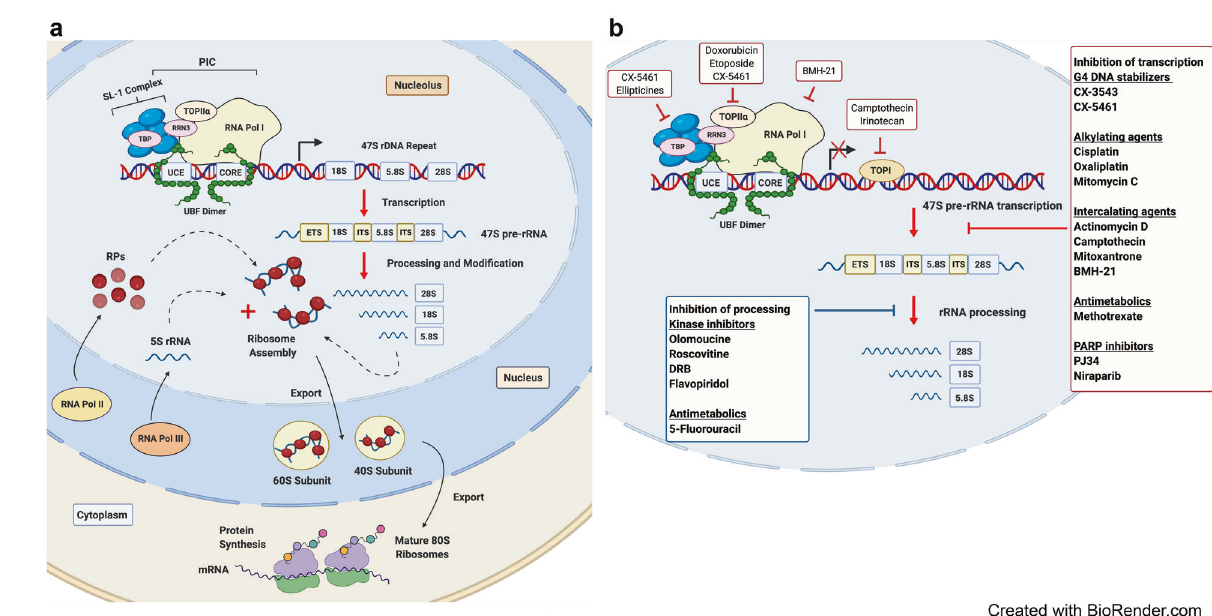
Fig. 1 A schematic representation of ribosome biogenesis in mammalian cells. a Ribosome biogenesis is a tightly coordinated process involving all three RNA polymerases (Pol I, Pol II, and Pol III). RNA Pol I transcribes the ribosomal RNA (rRNA) genes (rDNA) to produce the 47S precursor rRNA (47S pre-rRNA) transcript in the nucleolus. Pol I transcription initiation involves binding of the upstream binding factor (UBF) to the core promoter region (core) and upstream control element (UCE) of the rDNA promoters and facilitating the recruitment and binding of the selectivity factor 1 (SL-1) complex. SL-1 is composed of the TATA-box-binding protein (TBP) and fi ve Pol I-speci fi c TATA-box-associated factors (TAFs). This complex in turn recruits the Pol I-speci fi c initiation factor RRN3, which associates with DNA topoisomerase II α (TOPII α ) and Pol I to complete assembly of a transcriptionally-competent Pol I complex. Following transcription, the 47S pre-rRNA is subsequently cleaved and processed into the mature 18S, 5.8S, and 28S rRNA species. These molecules are then assembled along with ribosomal proteins and the 5S rRNA produced by Pol II and III, respectively, to form the major catalytic and architectural components of the small (40S) and the large (60S) ribosomal subunits. Once assembled, ribosomal complexes are exported from the nucleolus to the cytoplasm, where they form the mature (80S) ribosome required to initiate mRNA translation and thus protein synthesis. b A diverse range of anticancer drugs target ribosome biogenesis by inhibiting Pol I transcription and/or pre-rRNA